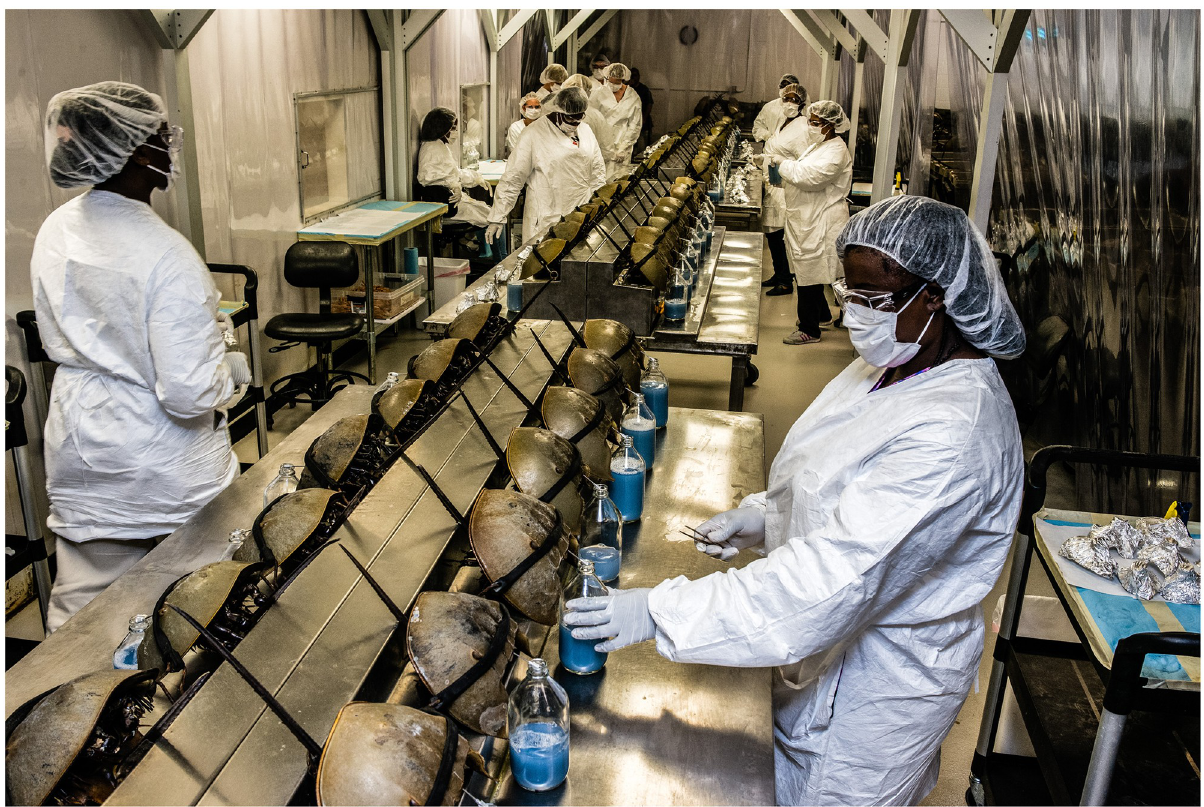
Fig 1. Horseshoe crabs are bled at the Charles River Laboratory in Charleston, South Carolina, US. Photograph by Timothy Fadek.